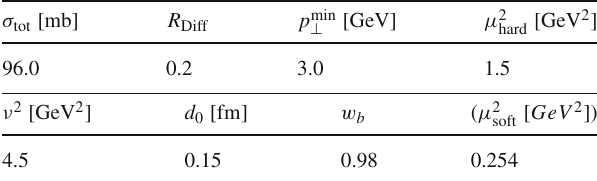
Table 1 The newly tuned parameters for minimum bias simulation and our baryonic spacetime colour reconnection model. The top row is the re-tuned parameters of the old Herwig 7 minimum bias model. The bottom row is the three new parameters of the spacetime components of our model, and a determined parameter of the old